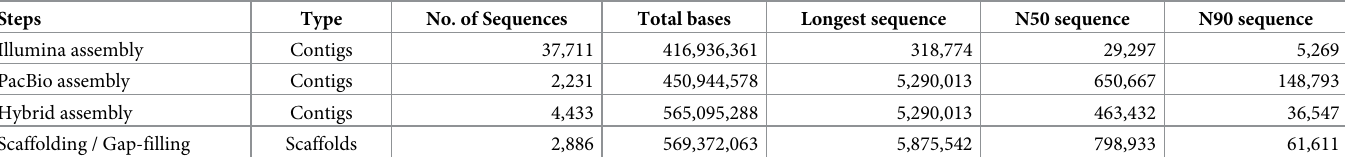
Table 1. Summary of Fagopyrum tataricum draft genome assembly process. Steps